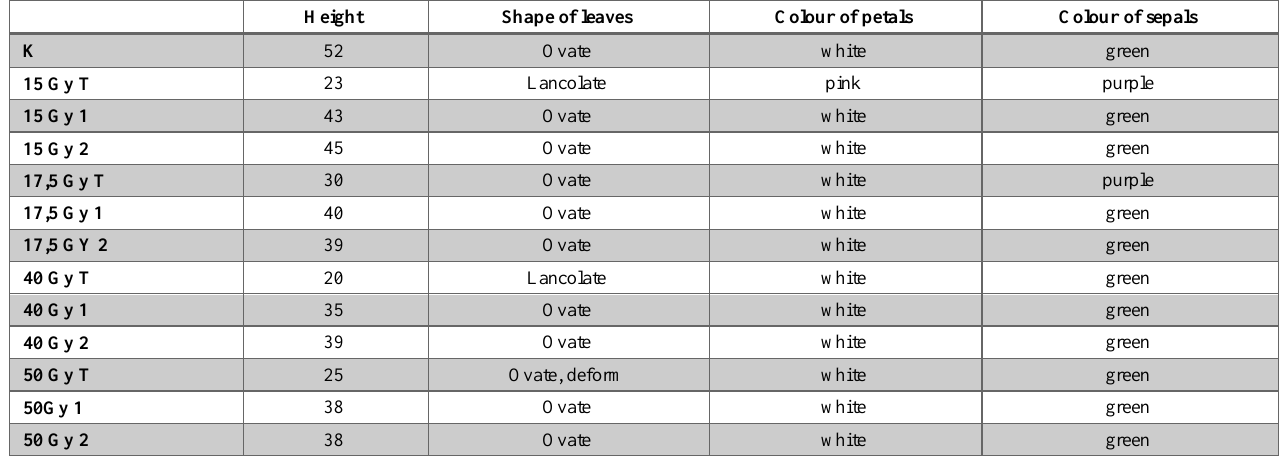
Table 2. Some morphology parameters of the selected Ocimum basilicum mutant